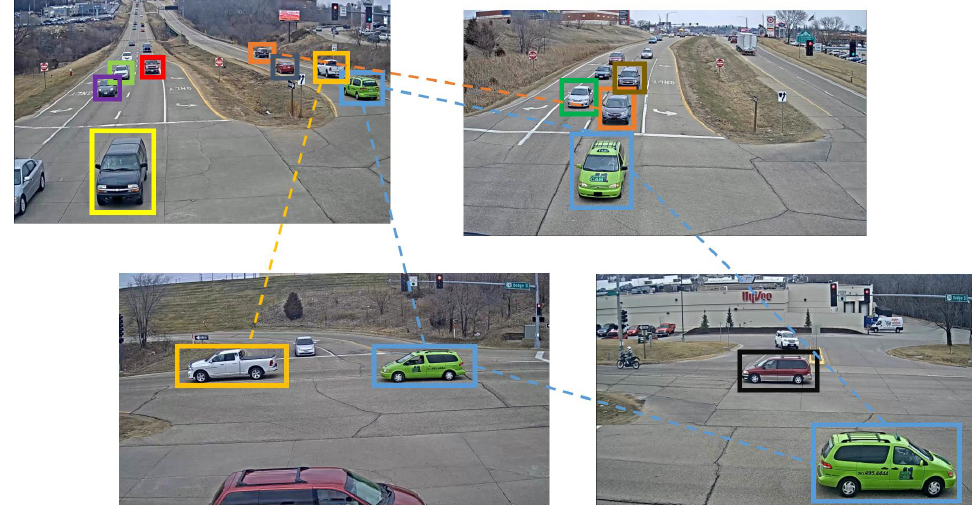
Figure 1. A multi-target multi-camera tracking example. The four subfigures show different views captured by cameras. The bounding box with the same color refers to the same car across